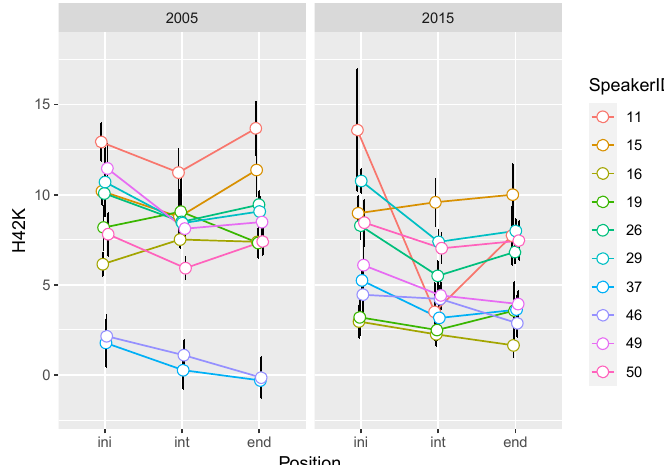
Figure A4. Speaker-specific data for H1A1.